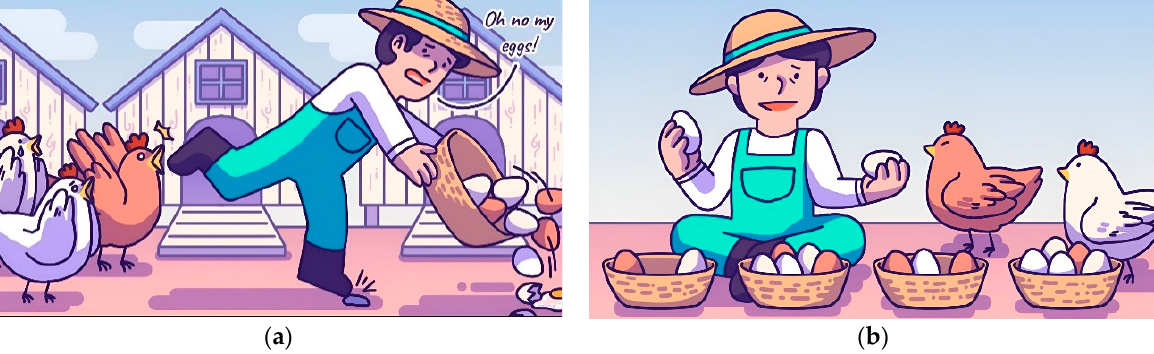
Figure 1. ( a ) (left) and ( b ) (right): Visual metaphors of the “risk diversification” concept. Source: www.thesimplesum.com. Available online: http://bit.ly/3Heb72U (archived on 23 January 2023).